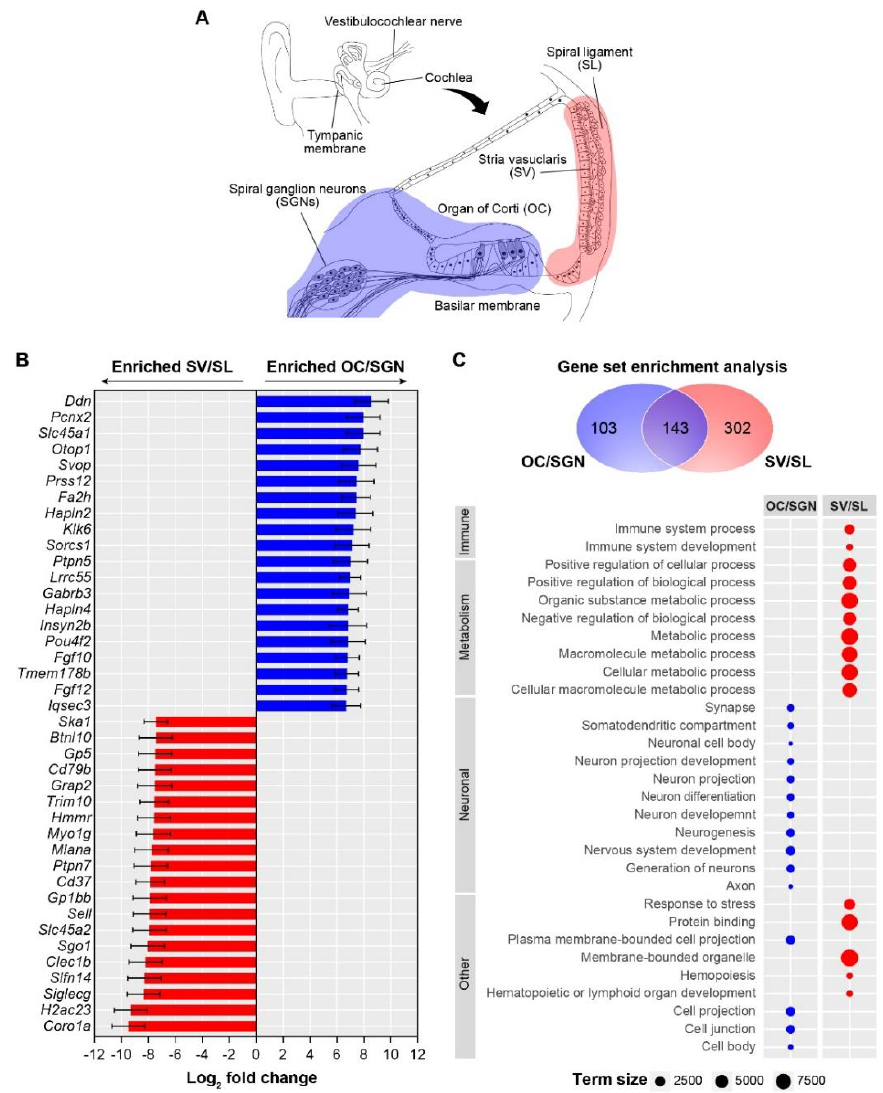
Figure 1. Cochlear substructures show distinct gene enrichment consistent with their distinct biological processes. ( A ) Transcriptomes were obtained from the two cochlear substructures: the sensorineural structures (blue), which included the organ of Corti together with the spiral ganglion neurons (OC/SGN), and the metabolic structures (red), which included the stria vascularis with the spiral ligament (SV/SL). ( B ) Differential expression analysis comparing cochlear substructures isolated from young mice reveals specific genes that are enriched in either the OC/SGN (blue bars) or the SV/SL (red bars). The 20 genes most enriched in each substructure are shown. ( C ) Gene set enrichment analysis revealed both unique and overlapping gene sets associated with specific biological processes (gene ontologies) in the OC/SGN (blue) and SV/SL (red). The top enriched biological processes are different between the OC/SGN (blue circles) and SV/SL (red circles). Term size is the number of genes included in the gene ontology. In some cases, genes defining the ontology are not expressed in the cochlear substructures. A complete list of enriched processes is available in Supplemental Table S2.